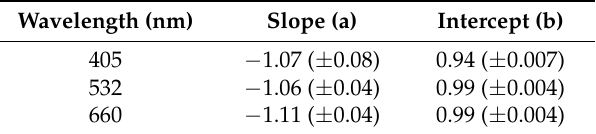
Table 2. The coefficients of the linear regressions relating single scattering albedo (SSA) at different wavelengths, λ , as the dependent variable to the EC/(EC + OC) ratio (see Equation (2)). The regressions were fitted previously [52] to the Fourth Fire Laboratory at Missoula Experiment (FLAME-4) data using the orthogonal distance regression method. The numbers in brackets are the standard deviations of the regression